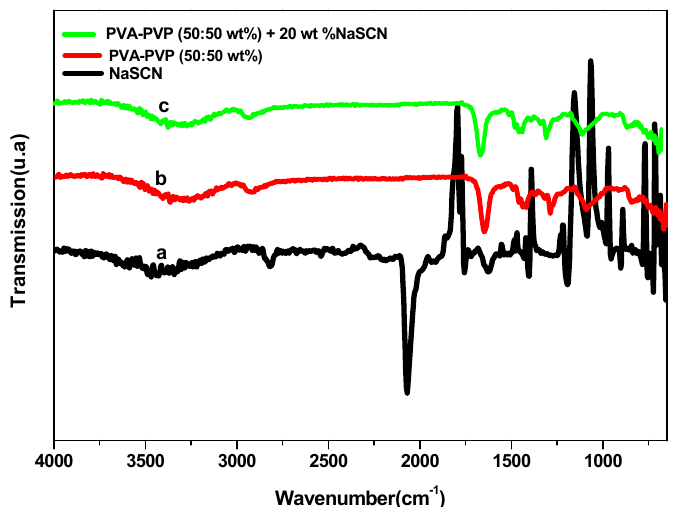
Figure 4. IR spectra of (a) NaSCN, (b) PVA: PVP (50:50 wt%) and (c) PVA: PVP (50:50 wt%) + 20 wt% NaSCN .